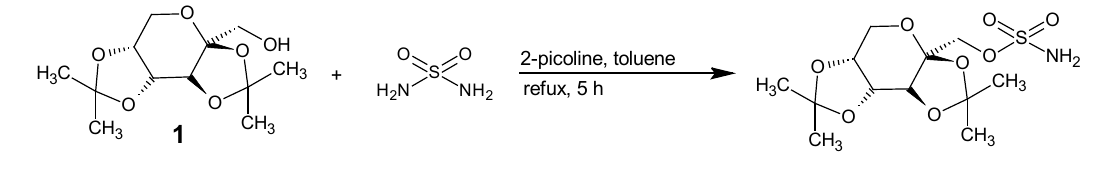
Fig. 1. Preparation of